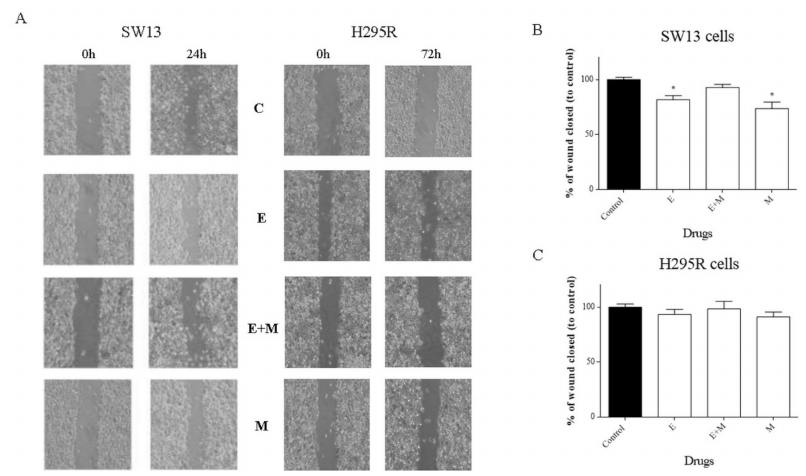
Figure 4. Cell motility assay for SW13 and H295R cells treated with EF24, mitotane, and their combination at 24 h and 72 h, respectively. ( A ) Representative images of the wound healing assay (C = control, E = EF24, M = mitotane, E + M = EF24 + mitotane). ( B,C ) Quantification of cell motility for SW13 and H295R cells. Results are expressed as the percentage reduction of the initial scratch compared with the corresponding untreated cells. Data are shown as the means of nine measurements. Experiments were performed in triplicate. Treatment vs. control: * p < 0.05.